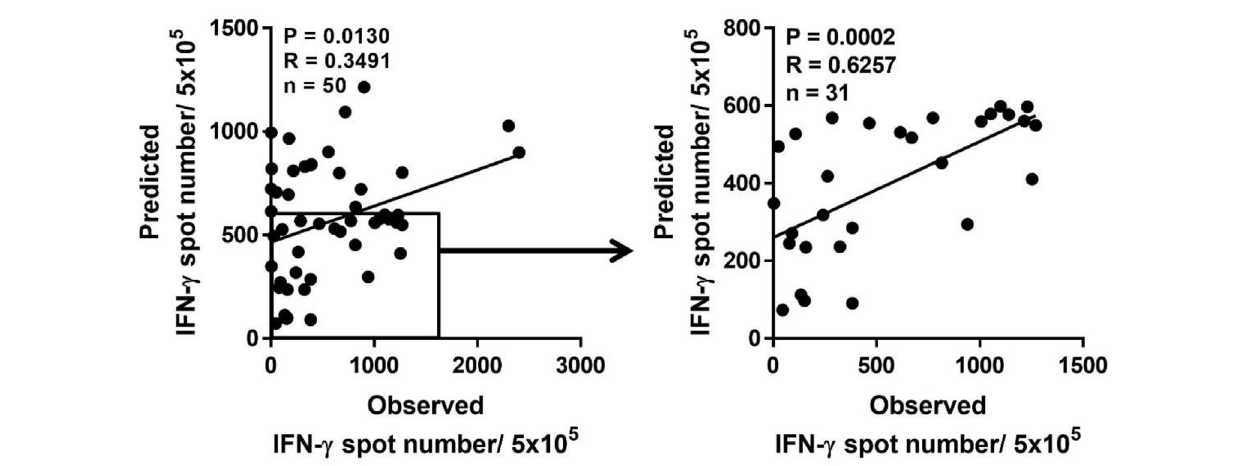
FigUre 6 | Prediction of pp65­specific CD8 + T cell responses in a certain individual based on the database of pp65­specific CD8 + T cell responses in each human leukocyte antigen (HLA) class I allotype. Based on the mean frequency of pp65­specific CD8 + T cells in each HLA class I allotypes obtained from 50 healthy donors, the sum of CD8 + T cell responses in each HLA class I allotype present in an individual was calculated as the predicted CD8 + T cell response, which was compared with the observed CD8 + T cell response. The predicted CD8 + T cell response was the most significant when the response was below 600. P and R values were calculated by Pearson’s correlation analysis.